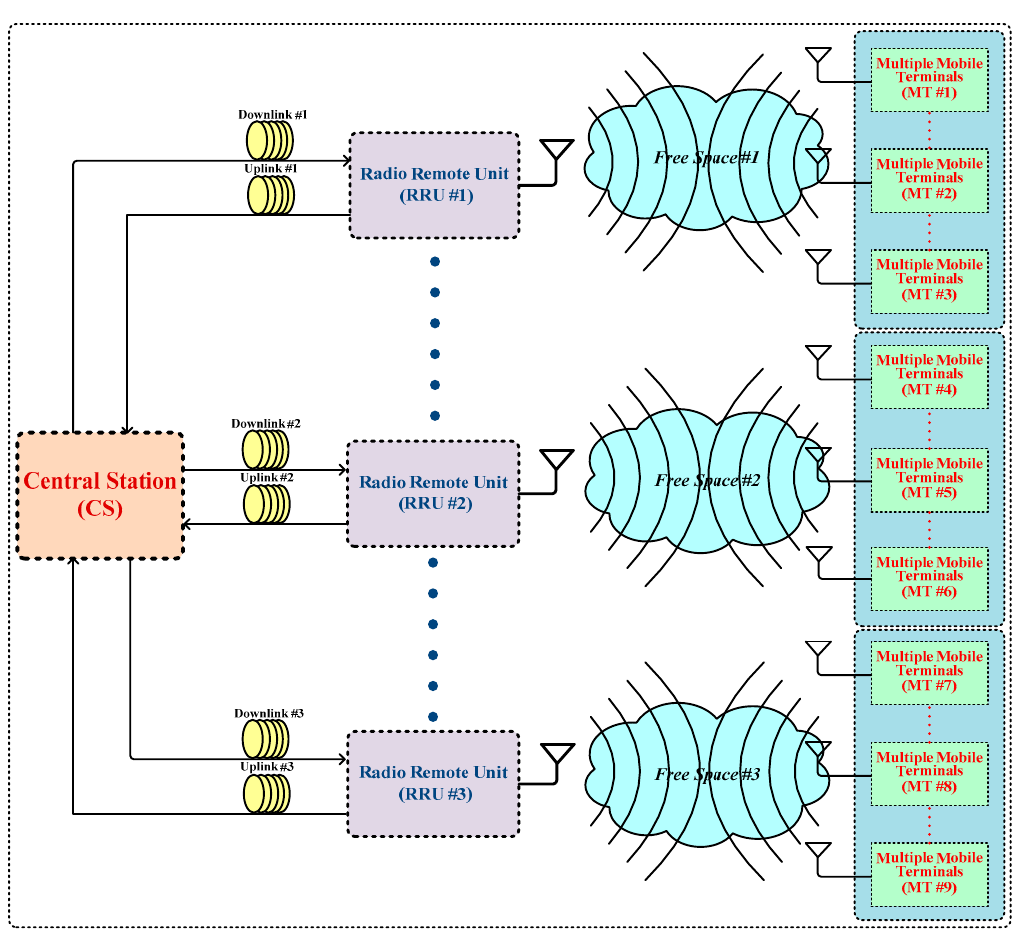
Figure 1. Setup for the radio over fiber (RoF) transmission system network.